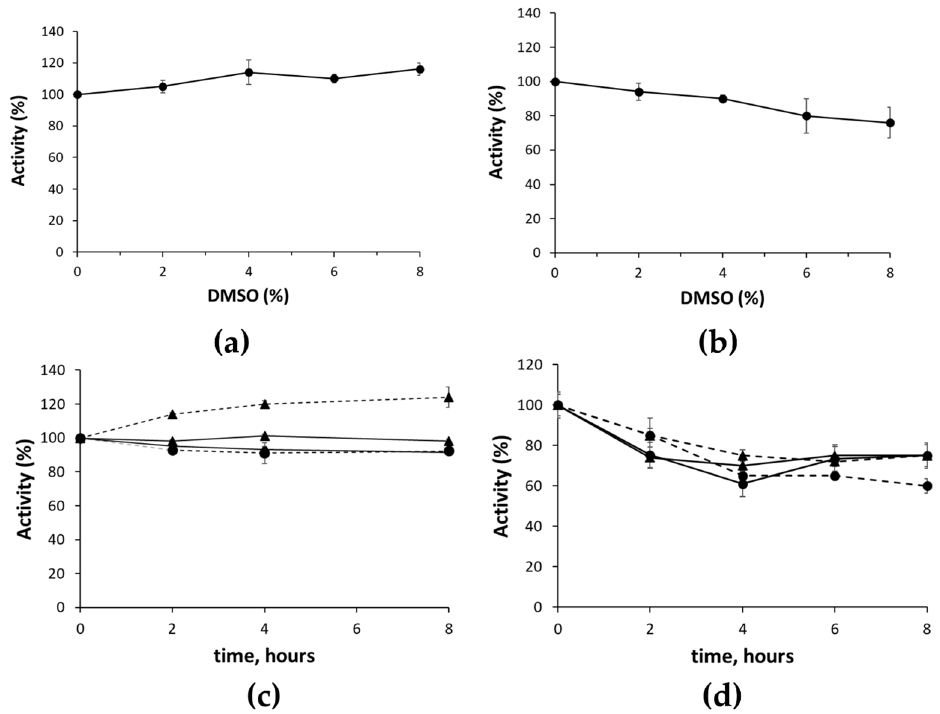
Figure 3. DMSO effect and reagents’ stability in NADH assay and resazurin/diaphorase assay. The effects of different amounts of DMSO on NAPRT activity was determined with NADH assay ( a ) and resazurin/diaphorase assay ( b ). Reaction mixtures, prepared as described in Materials and Methods section, contained the indicated concentrations of DMSO. The stability of the assay components in the NADH assay ( c ) and resazurin/diaphorase assay ( d ) was assessed by preincubating at 4 °C (continuous lines) or at room temperature (dotted lines) reaction mixtures containing all components except for DMSO and either NA (circle) or PRPP (triangle). At the indicated times, the reaction was initiated by adding an appropriate volume of the preincubated mixtures to wells containing DMSO (2.5% final concentration) and the missing substrate.